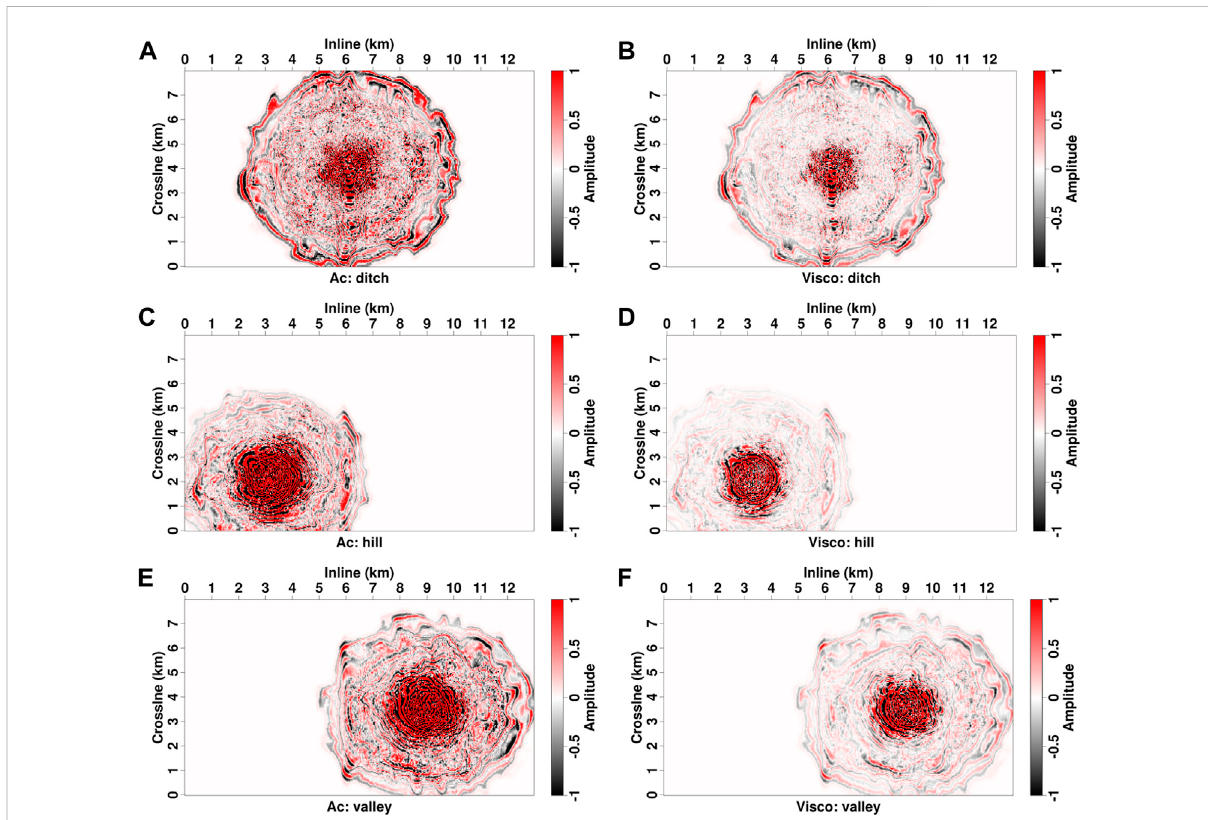
FIGURE 22 Acoustic (left column) and viscoacoustic (right column) wave fi elds on the topographic surface at 1.5 s. (A,B) , (C,D) , and (E,F) are the results excited by the source at three different locations,